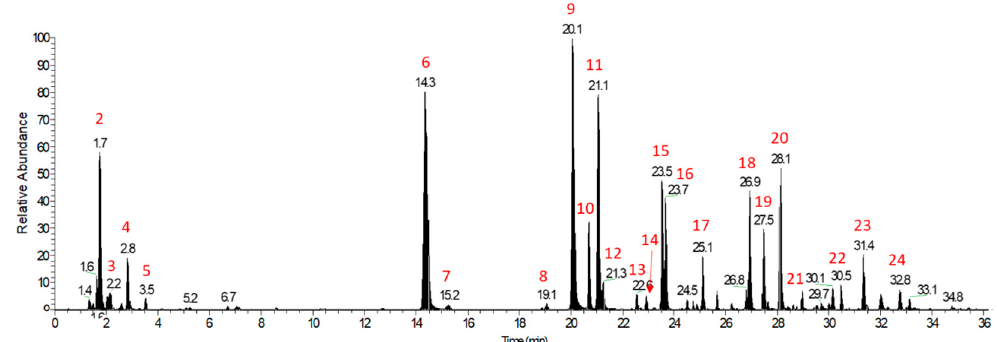
Figure 1. LC–MS base peak chromatogram (BPC) profile of whole coffee cherry extract (WCCE), adapted from the work of Nemzer and colleagues (under review) [27]. The major detected peaks were labelled with peak numbers ranging from 1 to 24, and the compounds corresponding to each peak are identified here: 1. gluconic acid; 2. quinic acid; 3. malic acid; 4. citric acid; 5. 2-hydroxyglutaric acid; 6. 3-O-caffeoylquinic acid (3-CQA); 7. protocatechualdehyde; 8. 3- coumaroylquinic acid (3-CoQA); 9. 5-CQA; 10. 3-feruloylquinic acid (3-FQA); 11. 4-CQA; 12. caffeic acid; 13. 5-CoQA; 14. 4-CoQA; 15. 5-FQA; 16. 4-FQA; 17. quinic acid-glucoside-R*; 18. 3-dicaffeoylquinic acid (3-DiCQA); 19. 5-DiCQA; 20. 4-DiCQA; 21. 3-Caffeoyl-5-FQA; 22. valeroylquinic acid (VQA) diglucoside-R*; 23. caffeoyl tryptophan; and 24. dimethylcaffeic acid. Other compounds identified in WCCE in the positive ion mode include pantothenic acid, trigonelline, choline, and glycerophosphocholine derivatives. Figure adapted from the work of Nemzer et al. (under review) [27]. A listing of the typical polyphenols found in WCCE can be found in Table 1.